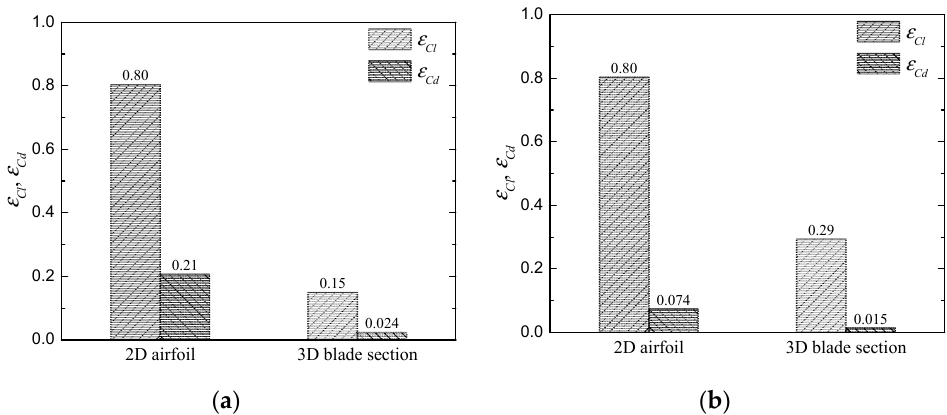
Figure 10. Lift and drag hysteresis intensities of the 2D airfoil and 3D blade section. ( a ) V w = 13 m/s; ( b ) V w = 15 m/s.